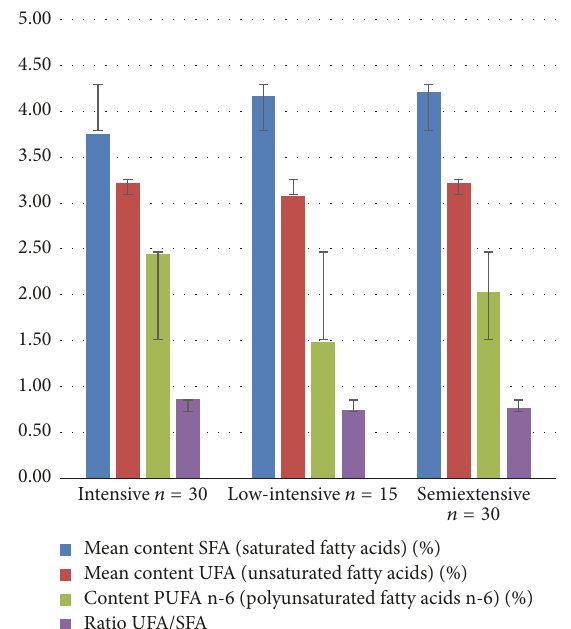
Figure 1: Selected parameters of fatty acid profile of carp muscle tissue under study.